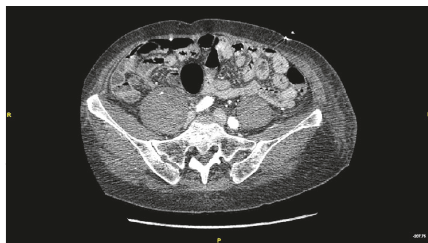
Figure 2: Computed tomography image with contrast in axial plane demonstrating right-sided iliopsoas hematomas as presented in case 2